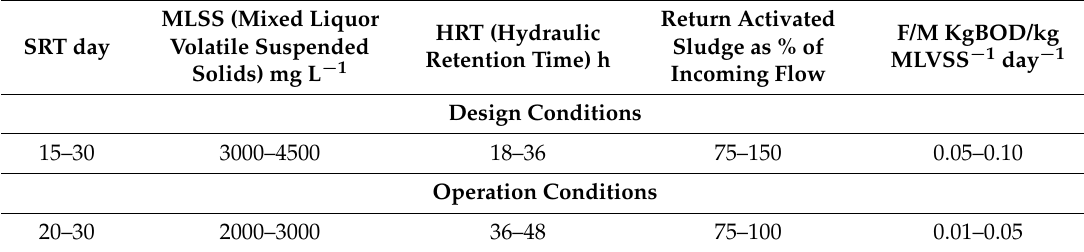
Table 1. Differences between the design and operation conditions of La Albuera